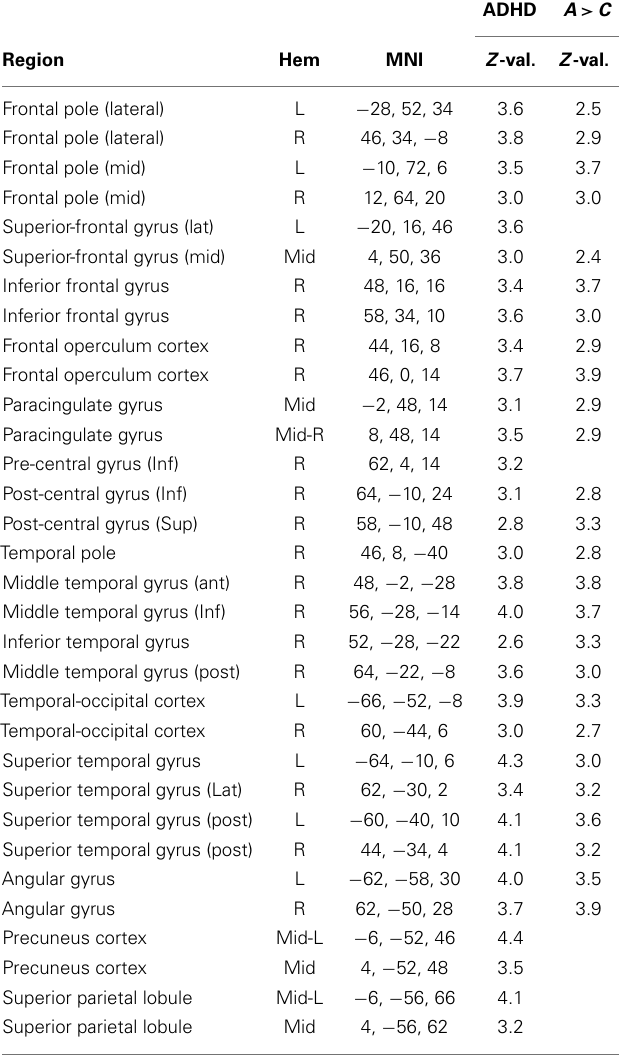
Table 7 |Visual network asymmetry association with BOLD signal during the letter task .